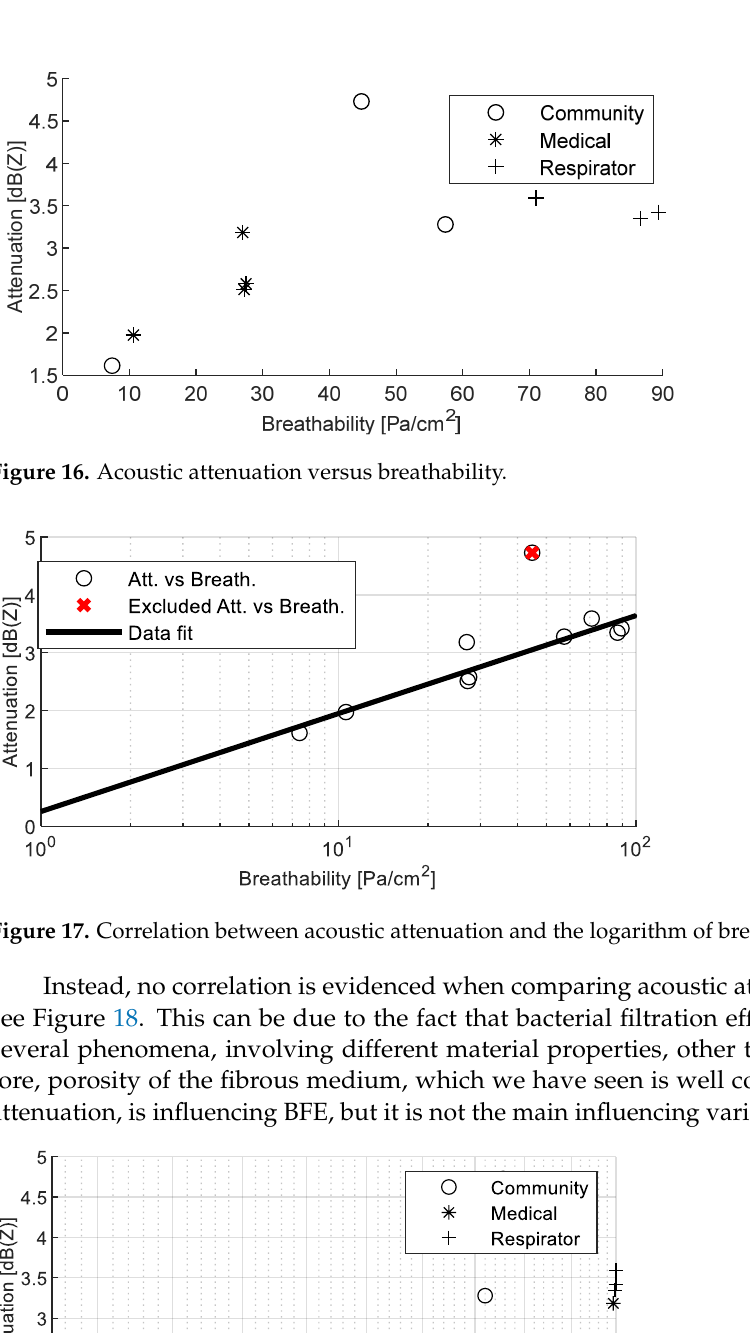
Figure 18. Correlation between acoustic attenuation and the logarithm of the BFE.